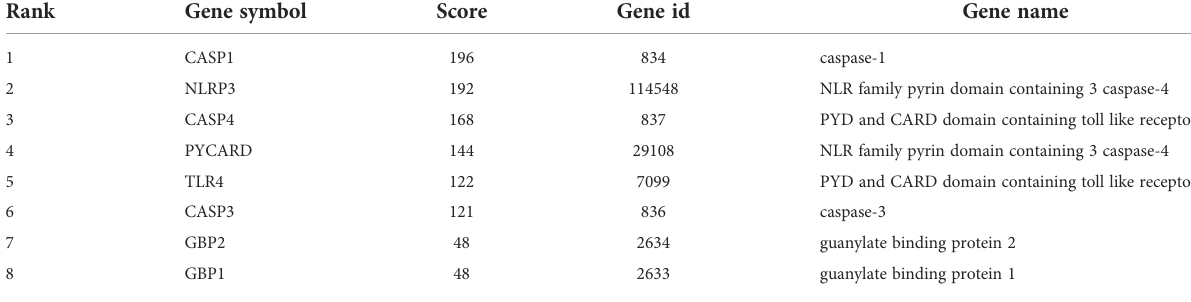
TABLE 4 PPI network of the top 8 hub